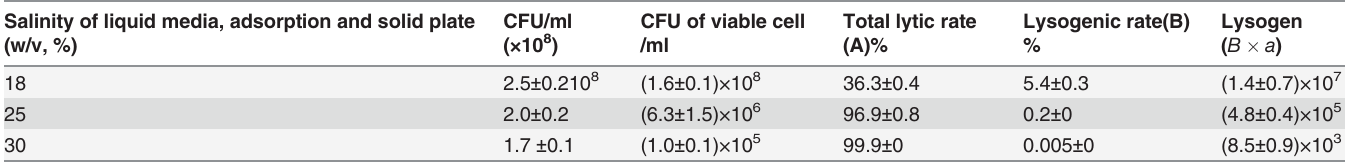
Table 2. Imitation of the interactions of SNJ1 and its host in natural niches. Salinity of liquid media, adsorption and solid plate (w/v,